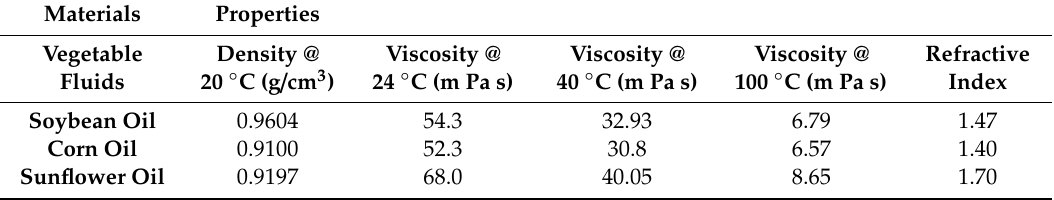
Table 1. Material